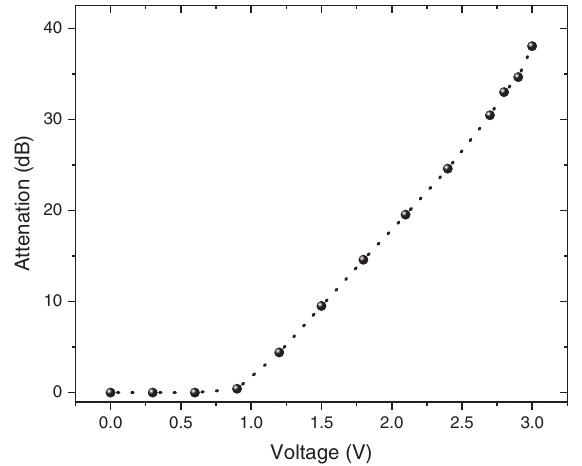
FIG. 9. Measured attenuation versus dc voltage. The maximum attenuation is 38 dB with applying a voltage of 3 V. The error bars are smaller than the data